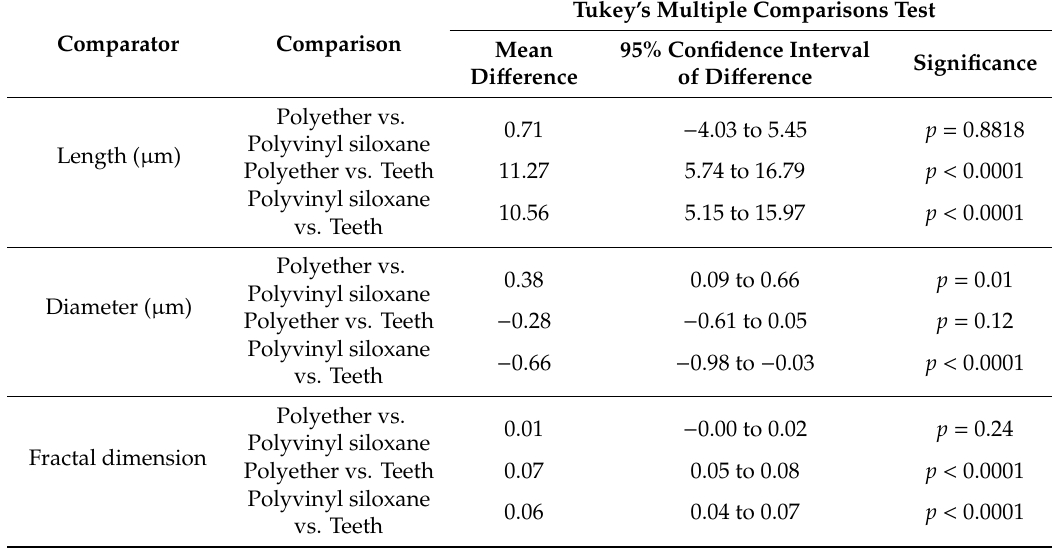
Figure 3. ( a,b ) Detail of a sample broken open to see the impression materials inside the dentinal tubules. Asterisks and arrows (b) show examples of the materials trapped in the dentinal tubules. Table 2. Analysis for the presence of impression tags between the groups in terms of length, diameter and fractal dimension. p < 0.05 (ANOVA; with post hoc Tukey’s multiple comparison tests).